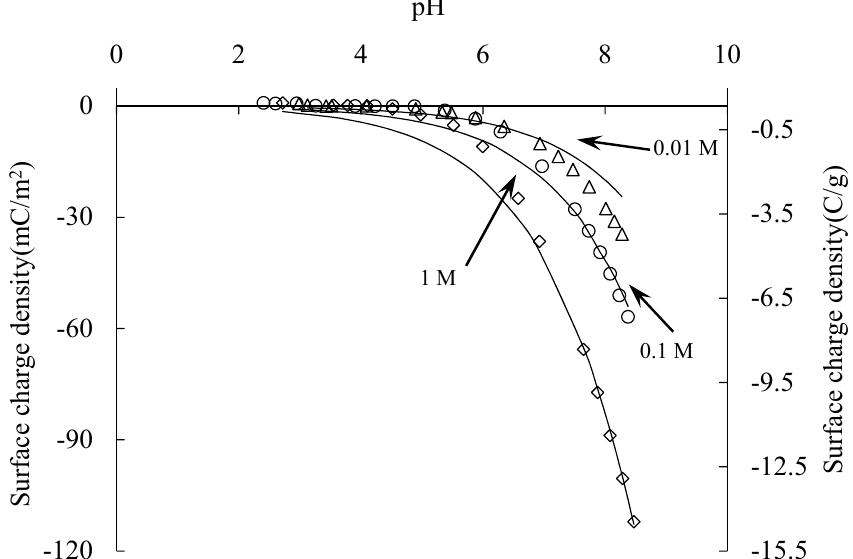
Figure 3. Surface charge density of silica. Symbols are measured values and the solid lines are calculated values by 1-pK basic Stern model.